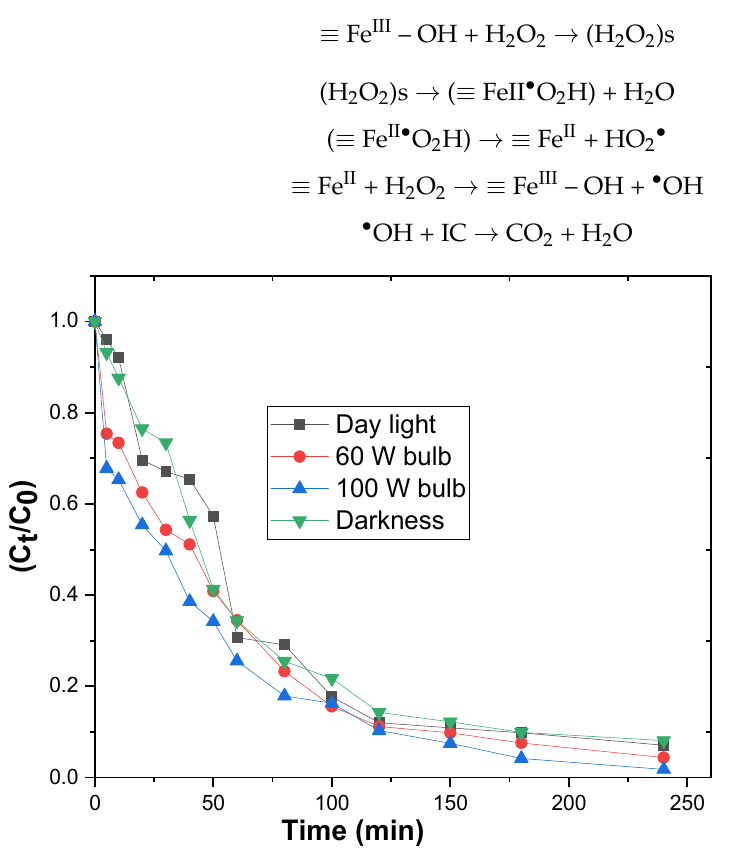
Figure 8. Effect of light intensity on indigo carmine degradation in the aqueous solution .